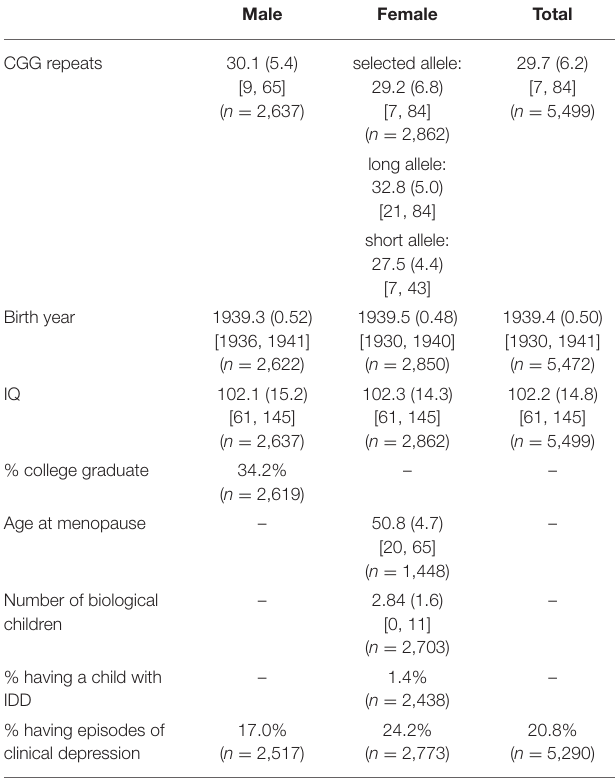
TABLE 1 | Descriptive statistics of study variables a